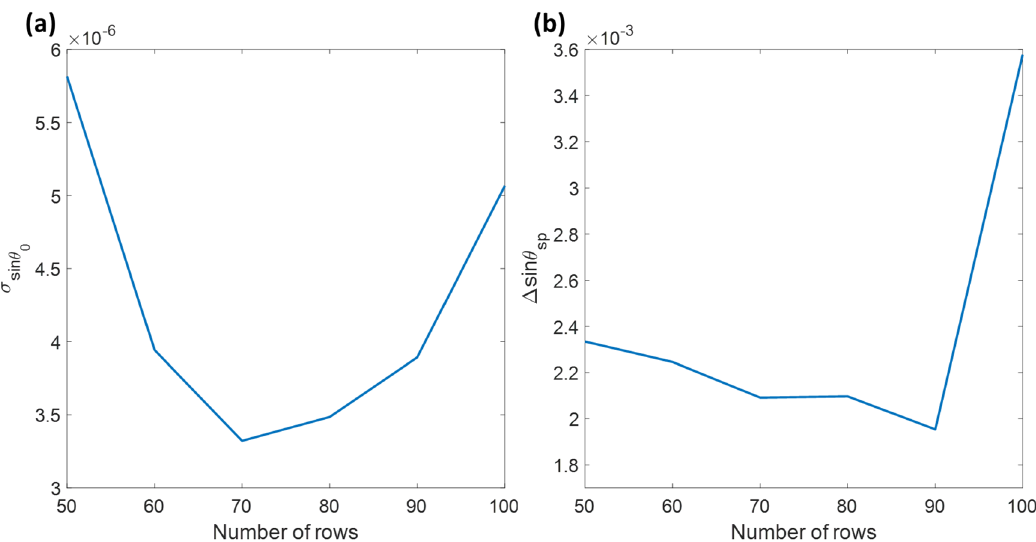
Figure 10. ( a ) σ of 100 recovered sinθ sp values, and ( b ) Δsinθ sp between the air and 150 psi cases using CNN networks with various input rows ranging from 50 to 100